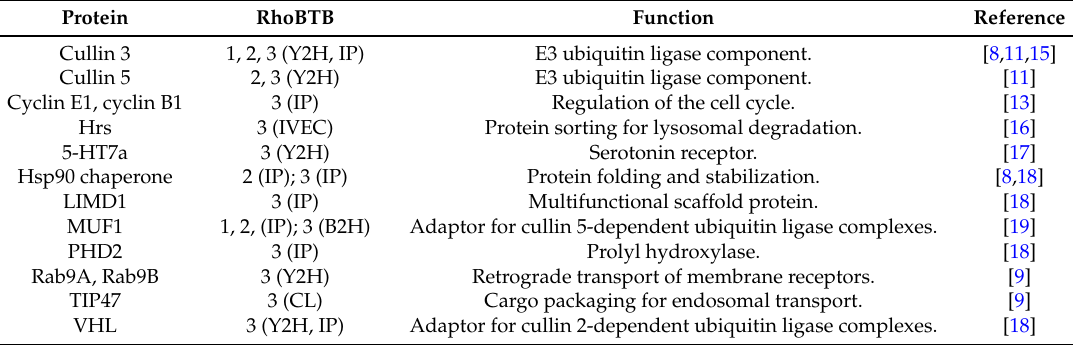
Adaptor for cullin 2-dependent ubiquitin ligase